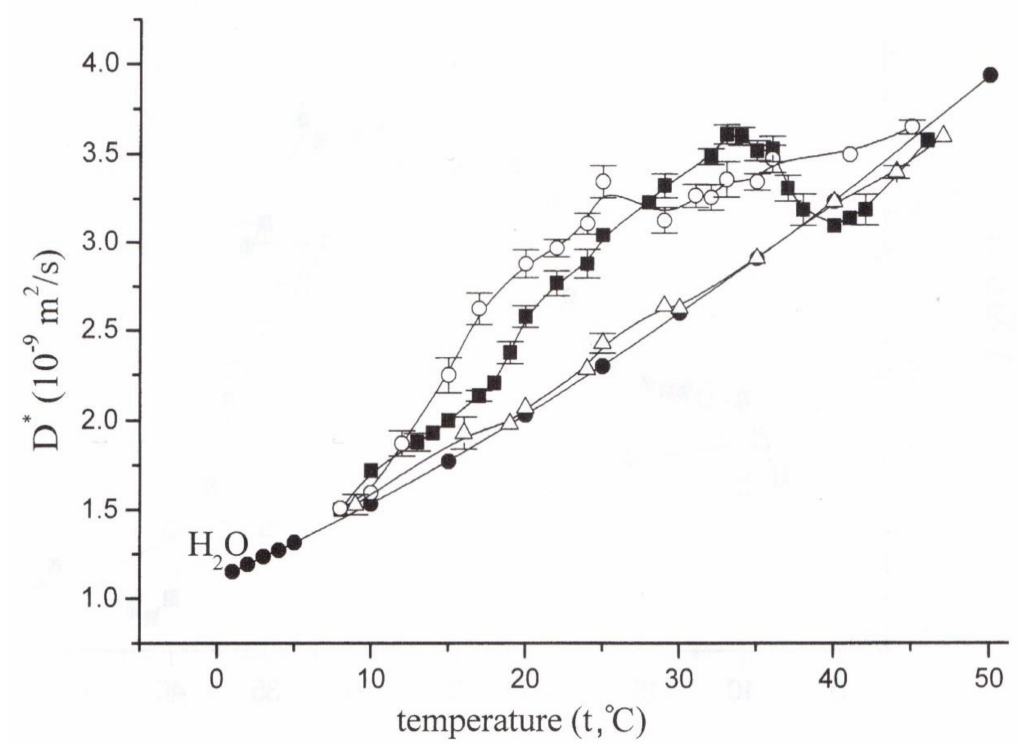
Figure 16. Temperature dependence of the diffusion coefficient of cytoplasmic water in the control ( (cid:4) ) and under the effect of gadolinium ( ), BDM ( ∆ ), and of bulk water ( • ) (cid:35)